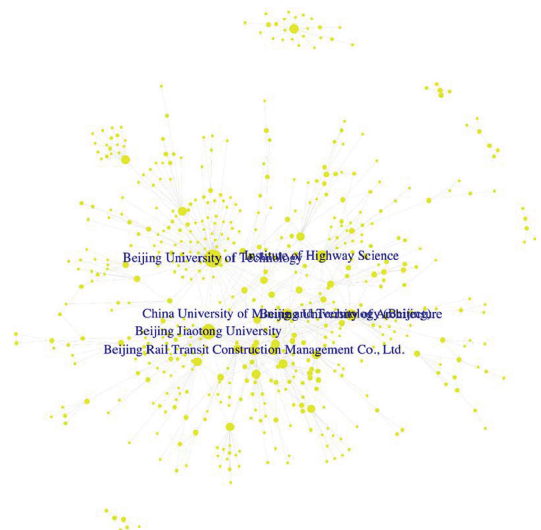
Figure 13: PetroChina community.